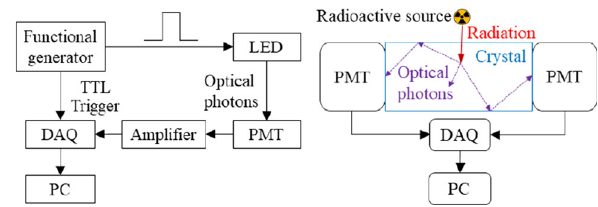
Fig. 3 Trigger logics for single-photoelectron response (left) and energy calibration (right)